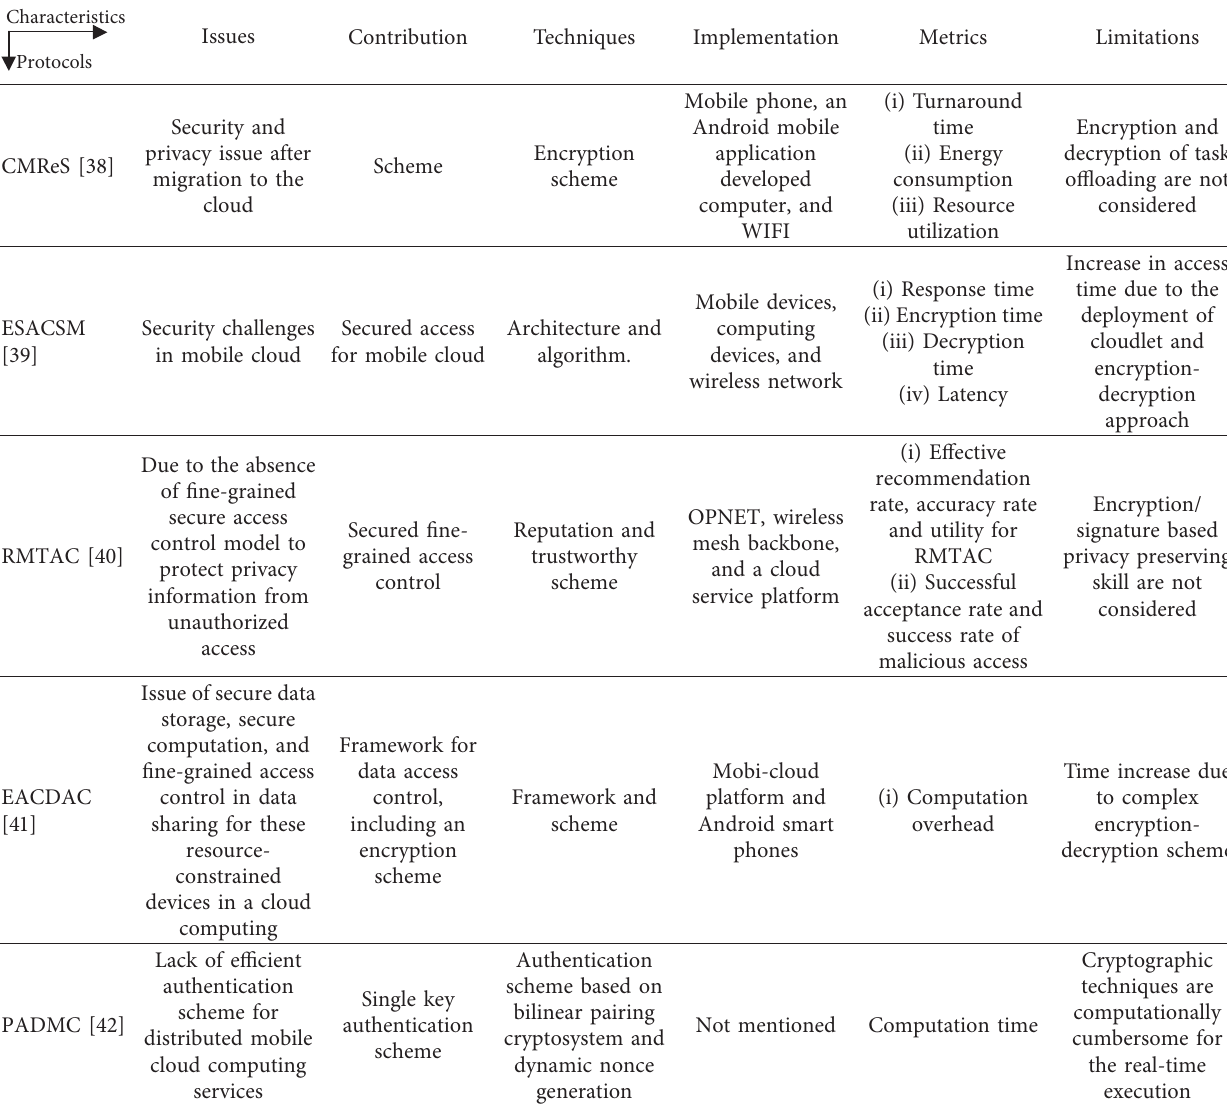
Table 3: Summary of security and privacy techniques in